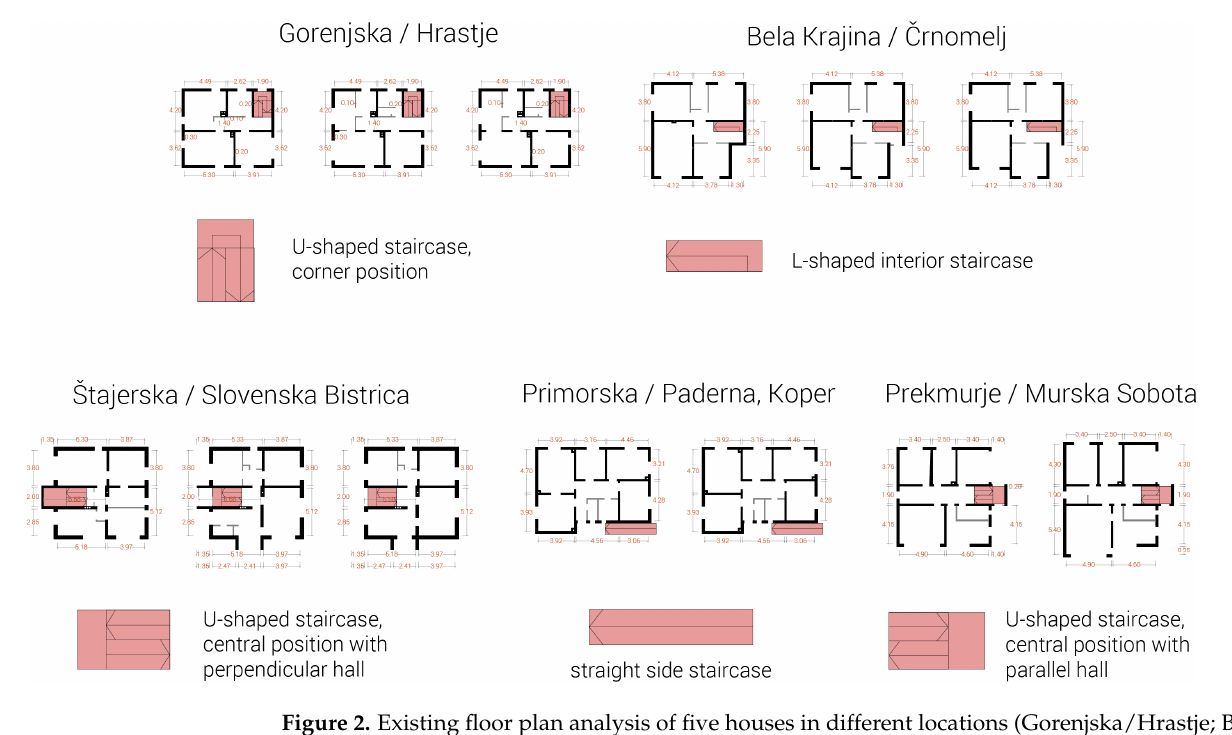
Figure 2. Existing floor plan analysis of five houses in different locations (Gorenjska/Hrastje; Bela Krajina/ Č rnomelj; Štajerska/Slovenska Bistrica; Primorska/Paderna, Loper; Prekmurje/Murska Sobota) (Ana Bel č i č , 2022).